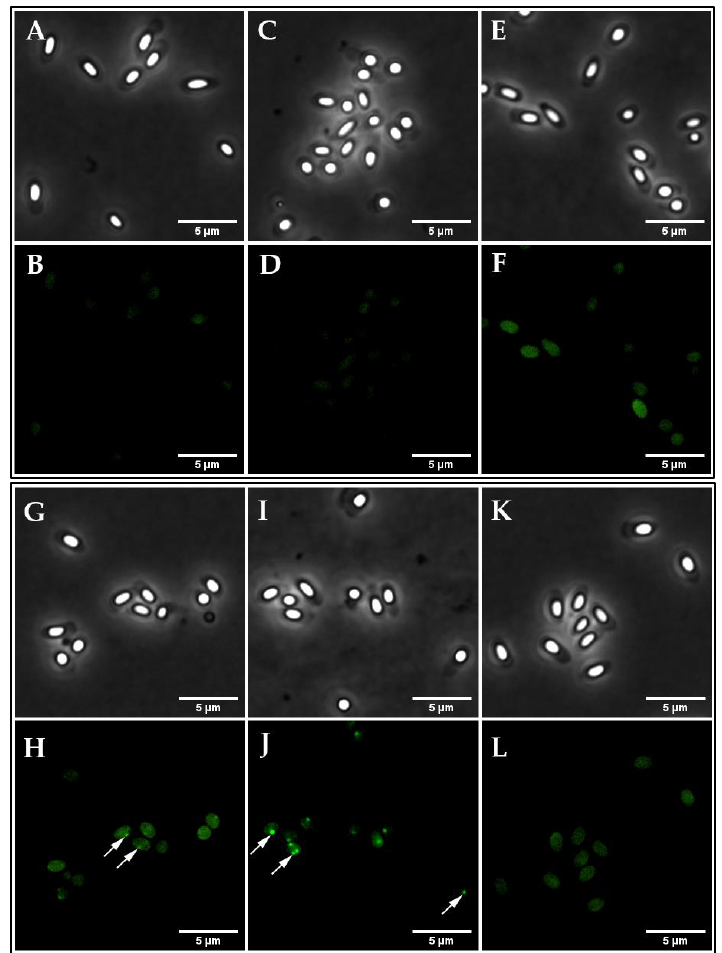
Figure 2. Visualization of the GerRB-SGFP2 germinosome in B. cereus dormant spores. Phase-contrast ( A , C , E , G , I , K ) and fluorescence microscopy images ( B , D , F , H , J , L ) of dormant spores harboring various plasmids including: ( A , B ) wild-type spores; ( C , D ) spores carrying pHT315; ( E , F ) spores carrying pHT315-P aphA3′ - SGFP2 ; ( G , H ) spores carrying pHT315-P gerR - gerRB - SGFP2 ; ( I , J ) spores carrying pHT315-P gerR - gerR - SGFP2 ; ( K , L ) spores carrying pHT315- gerRB - SGFP2 (no gerR promoter). Images were captured with a PH3 channel exposure time of 200 ms and an excitation channel at 470 nm using 10% laser power with an exposure time of 2 s The white arrows indicate some of the likely germinosomes in spores, and note the large heterogeneity in their fluorescence intensity. All panels are at the same magnification, and the scale bar is 5 μm.